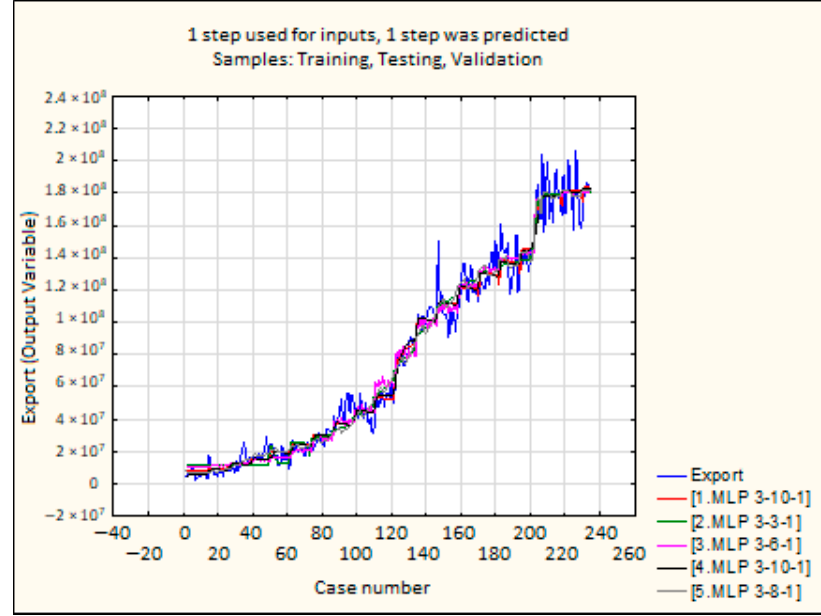
Figure 2. Equalized time series for retained networks (Experiment 1) . Source: Authors.